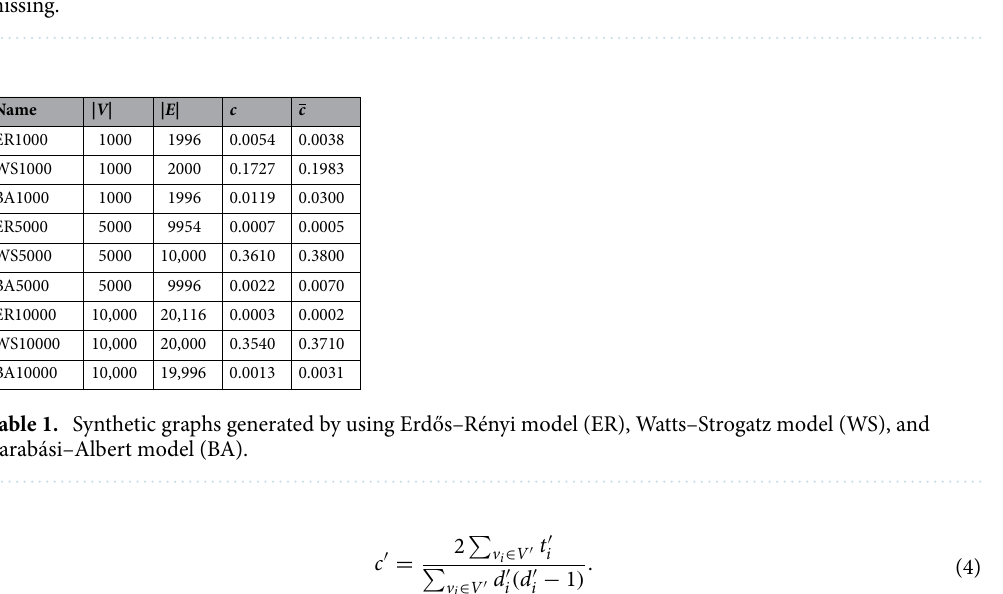
Figure 1. An example network (left) and the corresponding incomplete network (right) when node 6 is missing.